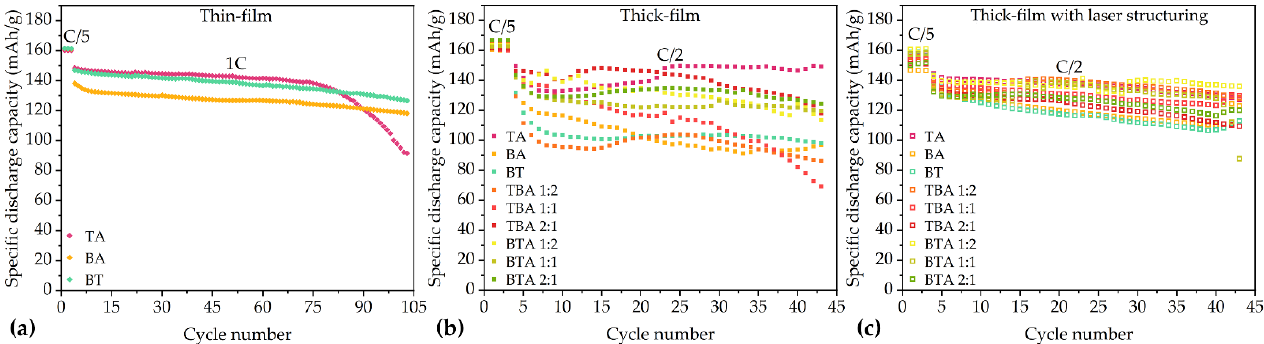
Figure 7. The results of long-term tests of the coin cells with different electrodes containing: ( a ) thin-film cathodes at 1C with 100 cycles; ( b ) thick-film cathodes at C/2 with 40 cycles; and ( c ) laser-structured thick-film cathodes at C/2 with 40 cycles.